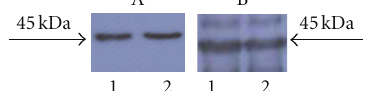
Figure 3: Illustration of expression of the transgene. Western blot analysis of BMP-2 expression in transformed E. coli. Panel A shows analysis of employing a poly-His tag antibody after 1hr of IPTG induction (labelled 1) and after 3 hrs of IPTG induction (labelled 2). Panel B shows analysis of employing an anti-BMP-2 antibody after 1hr of IPTG induction (labelled 1) and after 3hrs of IPTG induction (labelled 2).